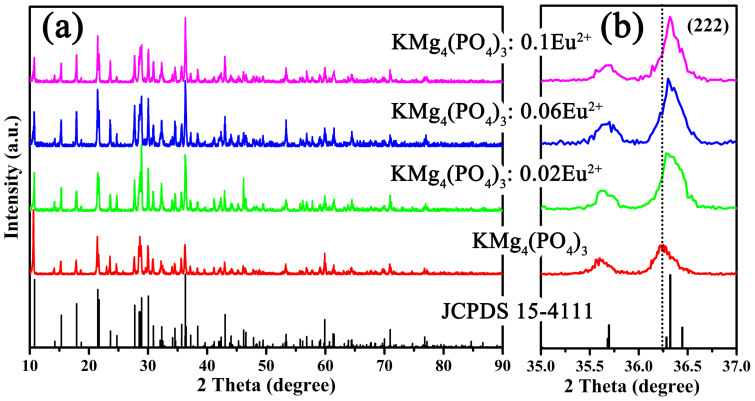
(a) XRD patterns of the as-prepared samples KMg4(PO4)3:xEu2+ (x = 0, 0.02, 0.06, and 0.1) and the standard pattern (JCPDS 15-4111). (b) The detailed XRD patterns ranging from 10° to 12° for the same samples.